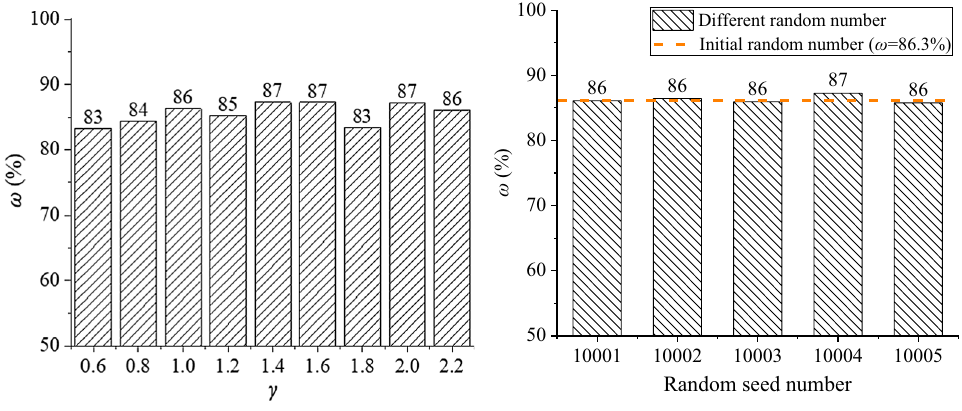
Fig. 20 Recovery rate of top coal with different density ratio and different random number